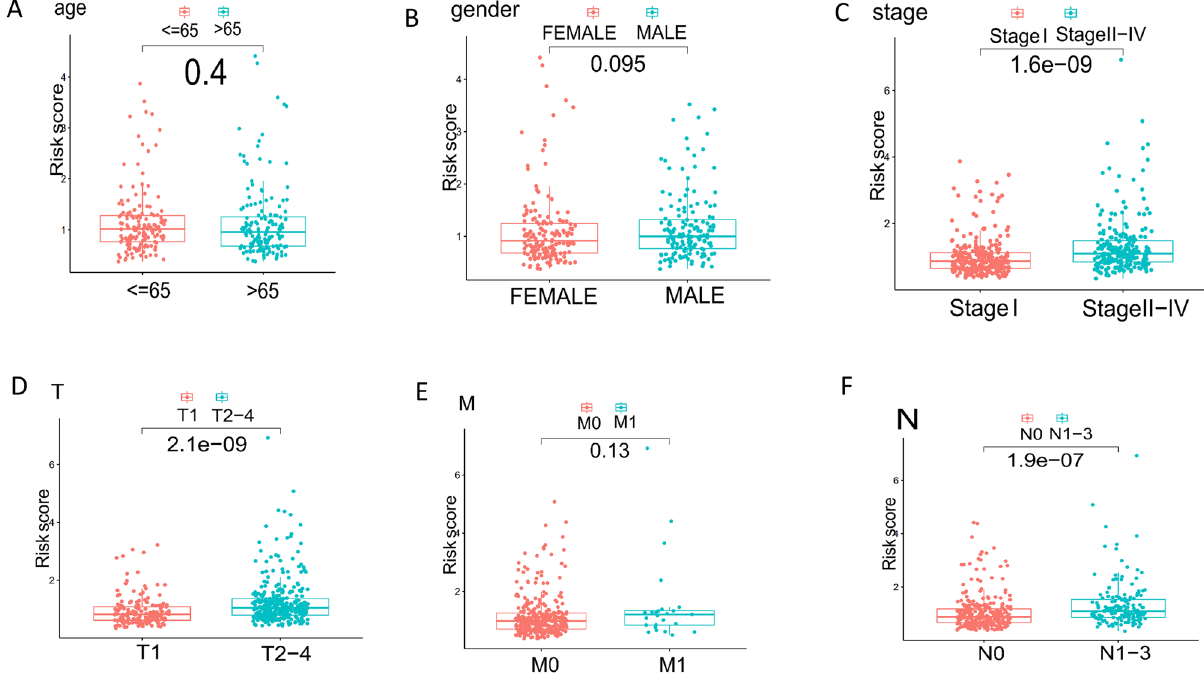
Figure 3. The relationships between risk score and multiple clinicopathological parameters. ( A ) Age. ( B ) Gender. ( C ) TMNStage. ( D ) Tumor size (T). ( E ) Distant metastasis (M). ( F ) Lymph node status